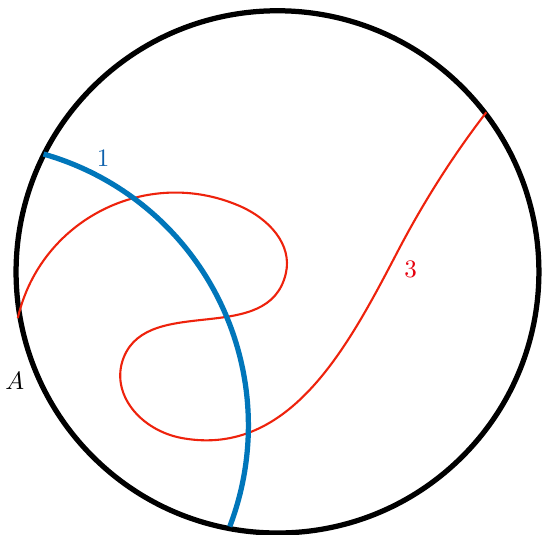
Figure 1 . The 2-thread shown crosses a total barrier of three. Since the program only requires the thread to cross a total barrier of one, complimentary slackness (CS) implies this thread will not contribute to any optimal